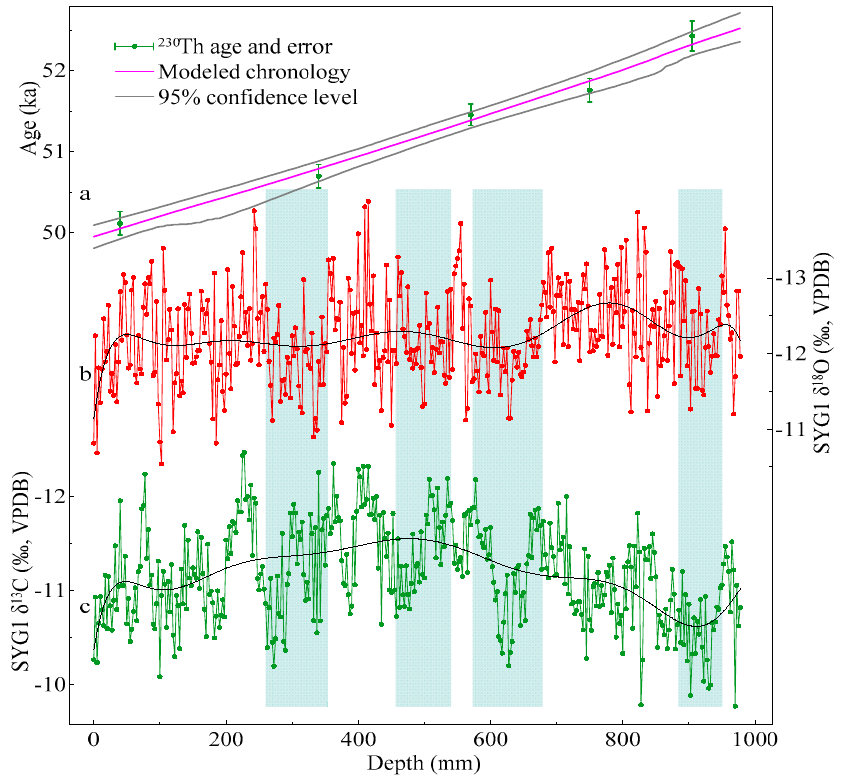
Figure 3. The age model ( a ), δ 18 O ( b ) and δ 13 C ( c ) isotopic sequences for Sample SYG1. The age–depth relation of SYG1 was reconstructed by a linear interpolation between adjacent dates, with error bars showing the dating uncertainties. Pink and gray lines denote the modeled age and 95% confidence level. Green dots and bars show dating results and errors. The red and green lines and dots represent δ 18 O ( b ) and δ 13 C ( c ), respectively. The solid black line shows the polynomial fitting of stalagmite SYG1 δ 18 O and δ 13 C.The light blue bars label the coeval isotopic enrichment.